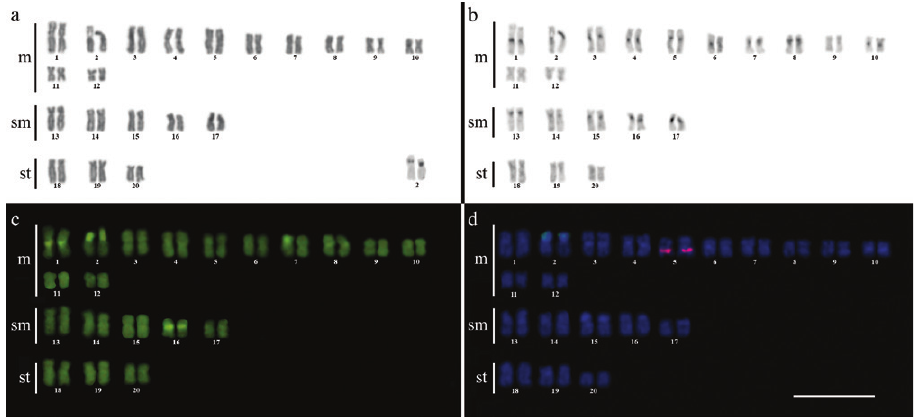
Figure 2a–d. Karyotype of G . sylvius after ( a ) conventional Giemsa staining, ( b ) C-banding, ( c ) CMA fluorochrome staining, ( d ) double FISH with 5S rDNA (red) and 18S rDNA (green) probes. Bar = 10µm.